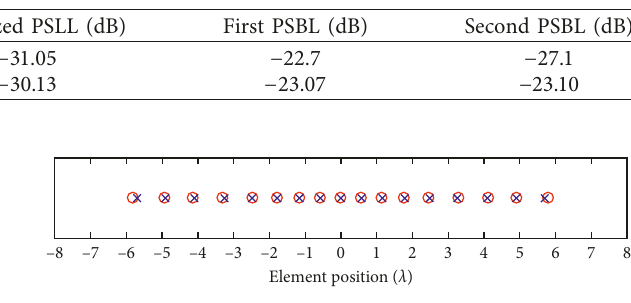
Figure 14: Position arrangement of the PS-modulated sparse array with in-phase and out-phase